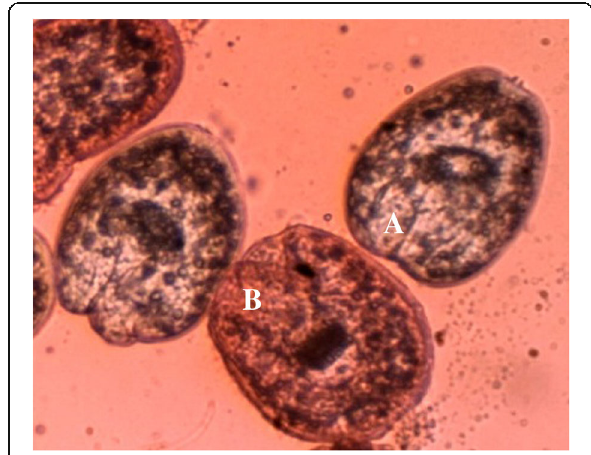
Fig. 1 Live ( a ) and death ( b ) protoscoleces of hydatid cysts after exposure with 0.1%